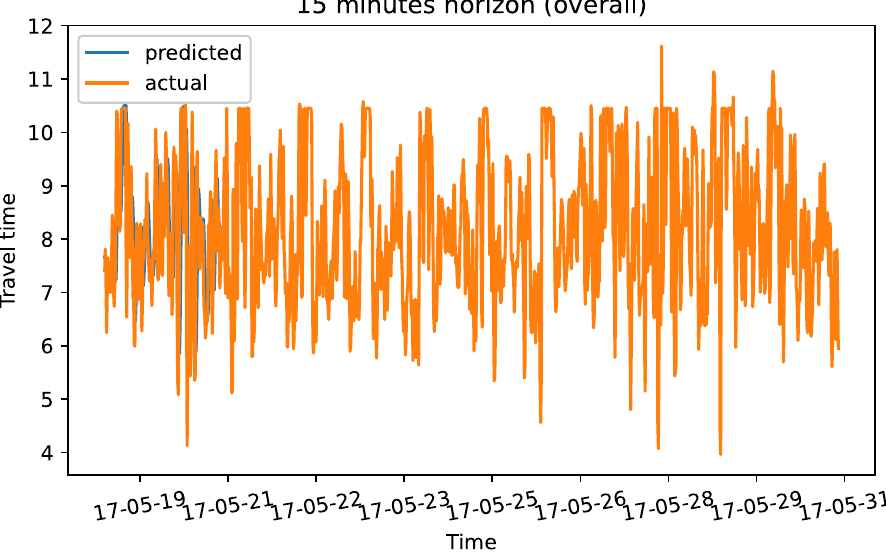
Fig 6. Prediction results for 15 minutes horizon on test data